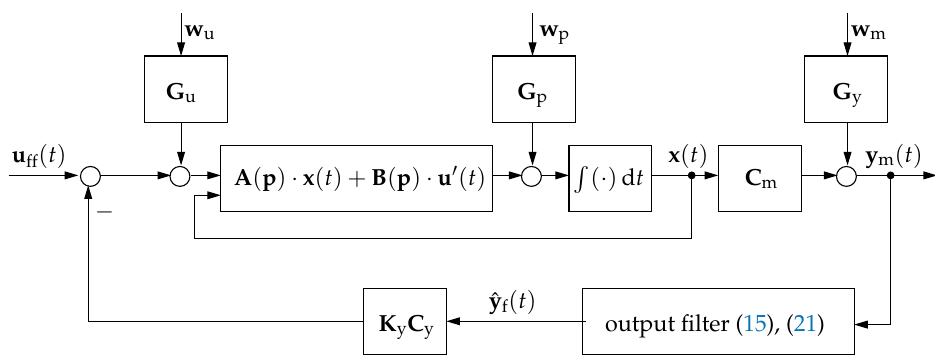
Figure 2. Filter-based output feedback control structure according to Case